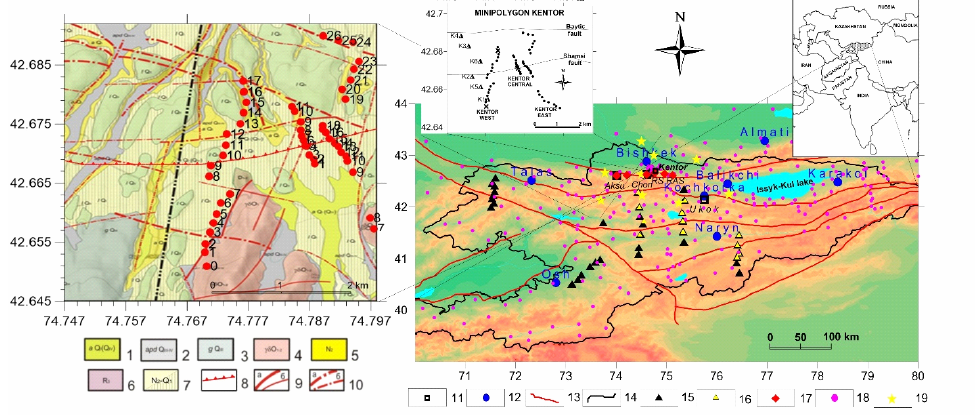
Figure 1. Location map of points of the geophysical monitoring, performed on the territory of the Central Tien Shan: 1 – modern alluvial boulder ‐ pebble deposits; 2 – alluvial boulder ‐ pebble deposits of the first above ‐ flood terrace; 3 – blocky ‐ pebble glacial deposits; 4 – Early and Middle Ordovician granodiorite; 5 – Miocene pebble ‐ crumbly ‐ sandy strata; 6 – Riphean complexes (undivided); 7 – Pliocene–Pleistocene alluvial boulder deposits of the Sharpyldak series; 8 – Shamsi fault; 9 – activated faults and fracture zones of the basement: a – main; б – secondary; 10 – activated faults assumed under the cover of modern sediments: a – main; b – secondary; 11 - points of stationary and profile magnetotelluric observations; 12 - settlements; 13 - main fault structures; 14 - the border of Kyrgyzstan; 15 - points of regime deep MTS; 16 - points of regime deep MTS of 2018; 17 - points of electromagnetic monitoring; 18 - points of the network of GPS observations; 19 - KNET teleseismic network